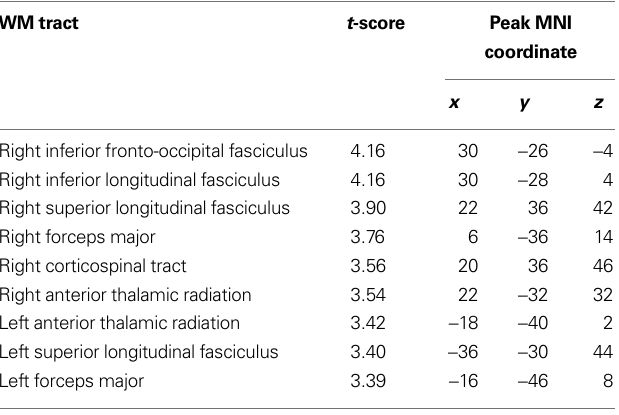
Table 4 | MNI coordinates of brain areas that showed signifi cant* white matter defi cits in children with DD.